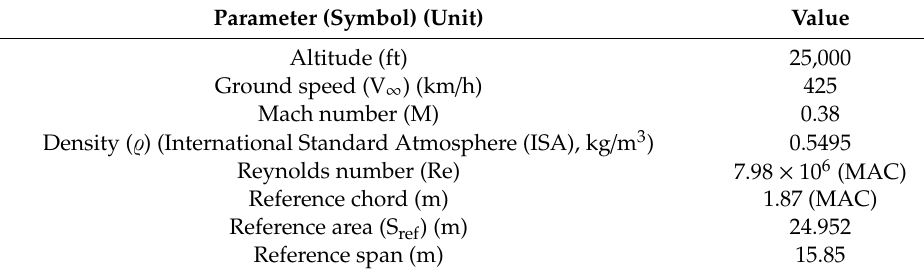
Table 7. Cruise reference conditions (geometry information from